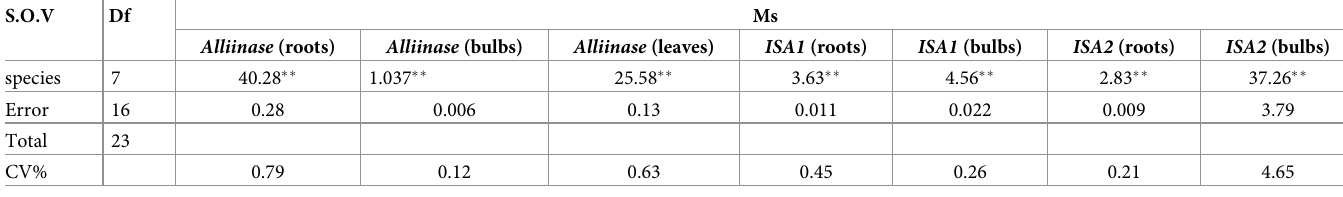
Table 3. ANOVA for three isoforms expression levels of alliinase involved in allicin biosynthetic pathway in Allium species. S.O.V Df